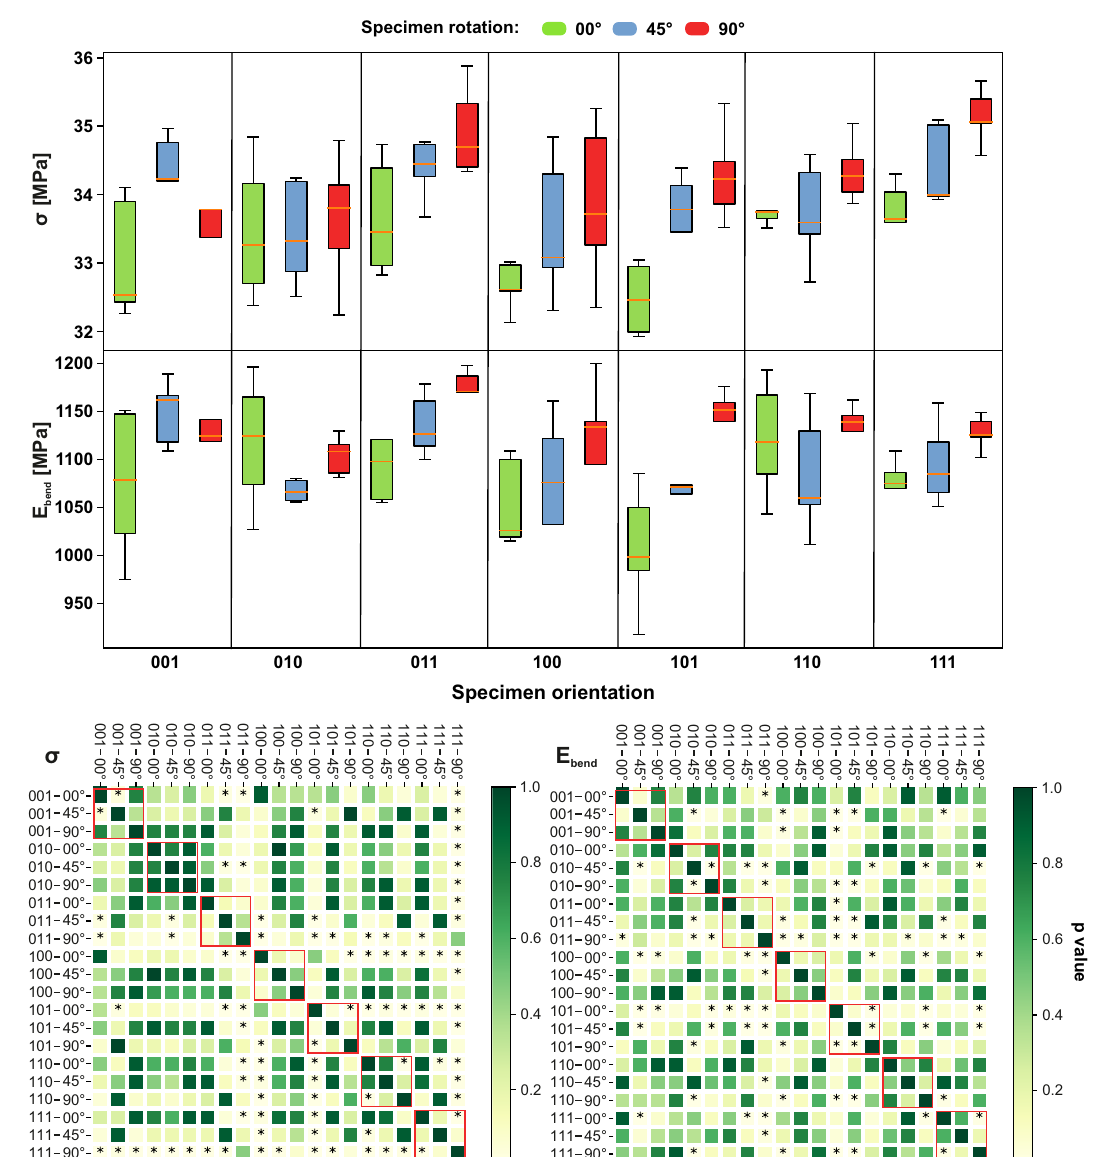
Figure 14. The impact of different sample orientations on flexural strength ( σ ) and flexural modulus ( E bend ) values. The red border in the heatmap highlights specimens with equal orientation. The members marked as * express a statistically significant